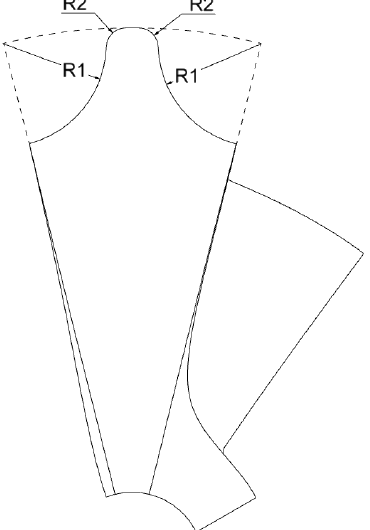
Figure 24: Additional variable parameters used during optimisation using method